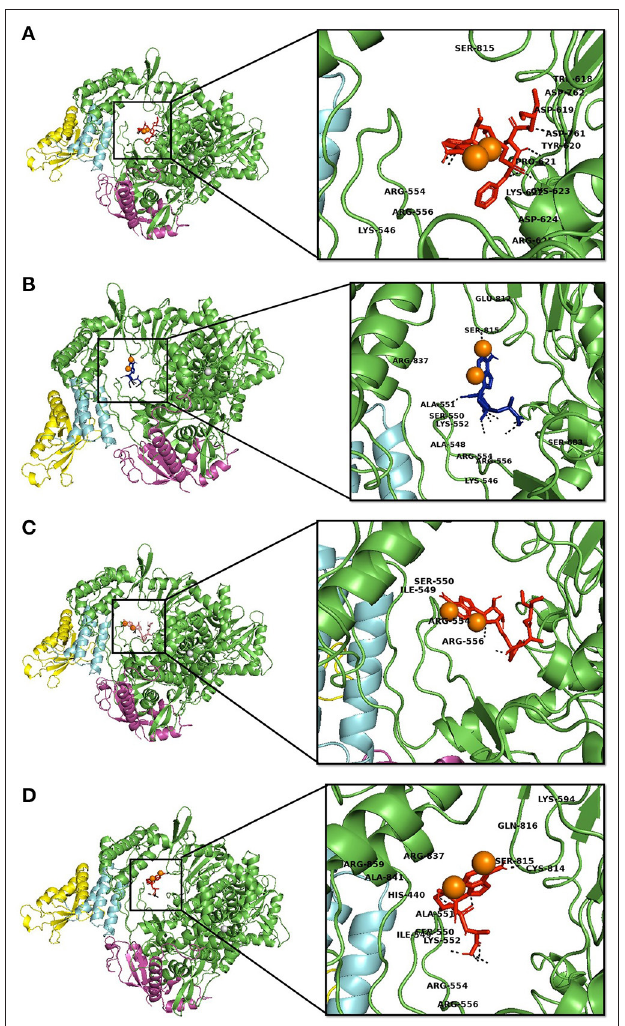
FIGURE 2 | Interaction of Remdesvir and the novel lead compound with the native RdRp and RdRp with the mutation. (A) Native RdRp with Remdesvir, (B) Native RdRp with novel lead compound (SCHEMBL20144212), (C) Mutant RdRp with Remdesvir, (D) Mutant RdRp with novel lead compound (SCHEMBL20144212).